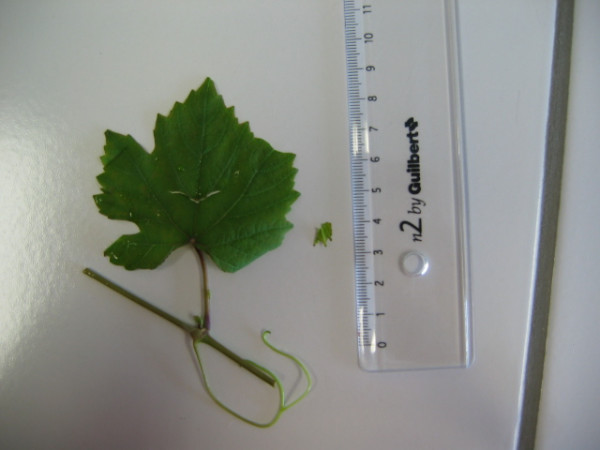
Asymmetric leaf of a 3 year-old atypical somaclone n°21 plant.